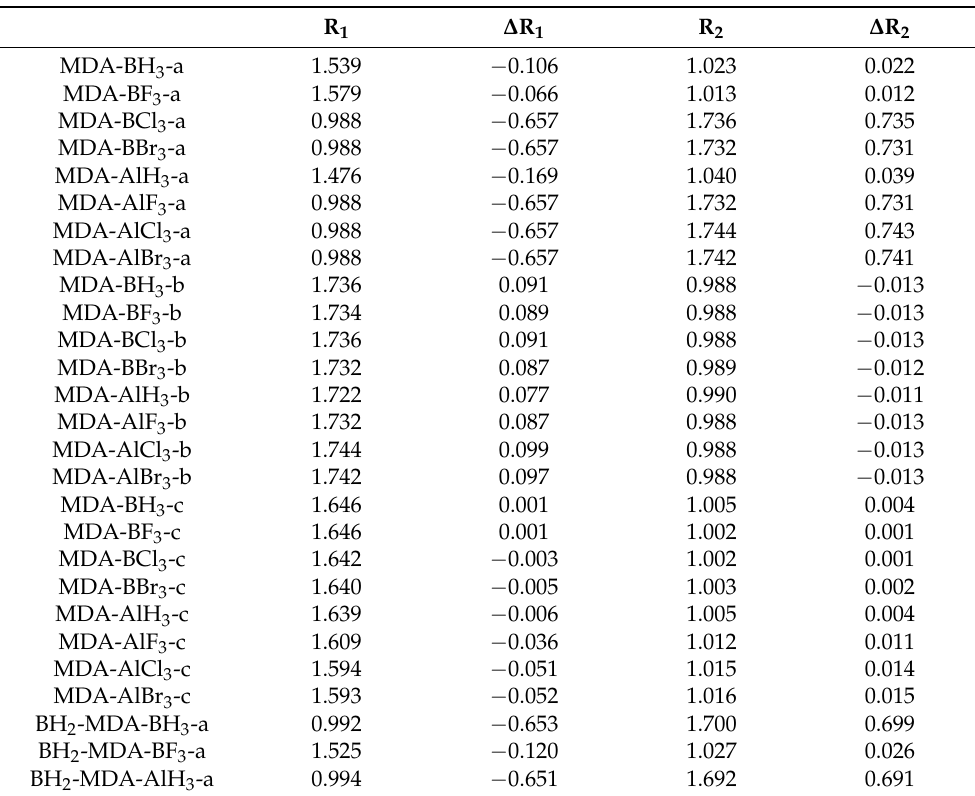
Table 3. H ··· O distance (R 1 ) and O-H bond length (R 2 ) in the complexes as well as their difference ( ∆ R) relative to the monomer, all in